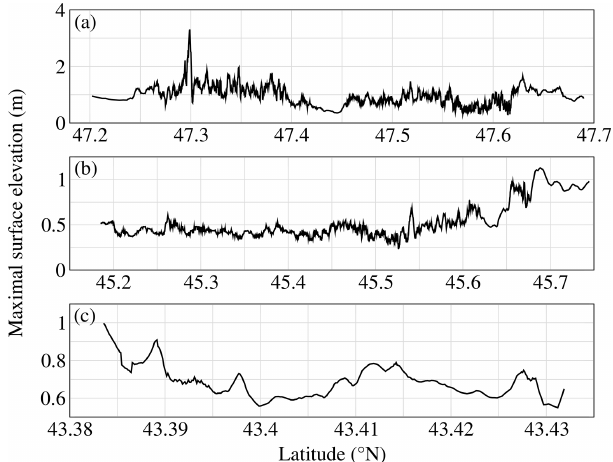
Figure 20. Maximum surface elevations (m) computed by FUNWAVE-TVD for the 80km 3 scenario from the generation area to the French coasts and other remote territories at a 2.7km res- olution. The red rectangle represents a daughter grid covering the western French coasts (see Figs. 5 and 21).